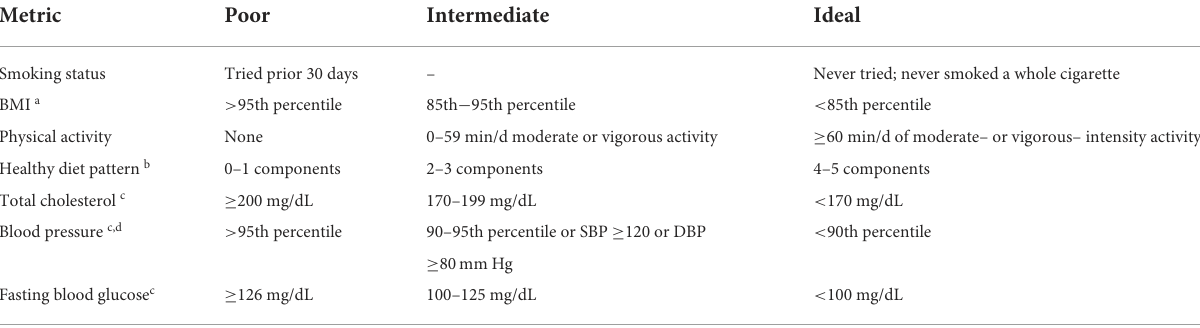
TABLE 1 Poor, intermediate, and ideal definitions of cardiovascular health metrics in Chinese children and adolescents using a modified American Heart Association